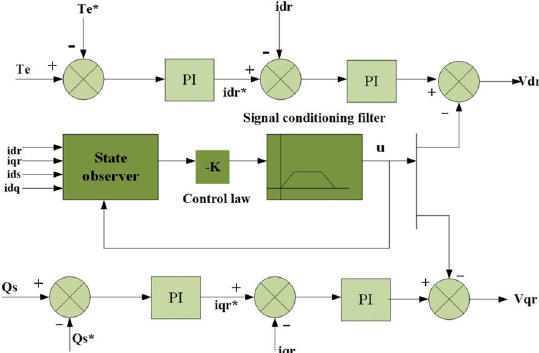
Fig. 11 The supplementary SSI damping Observer-based state-feedback controller